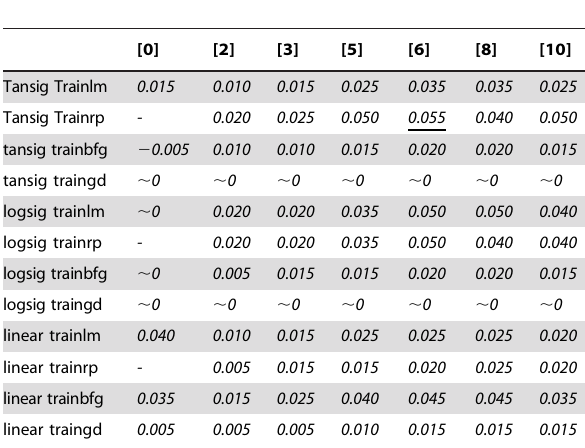
Table 2. Correlations for each parameter combination used for optimization the neural network.